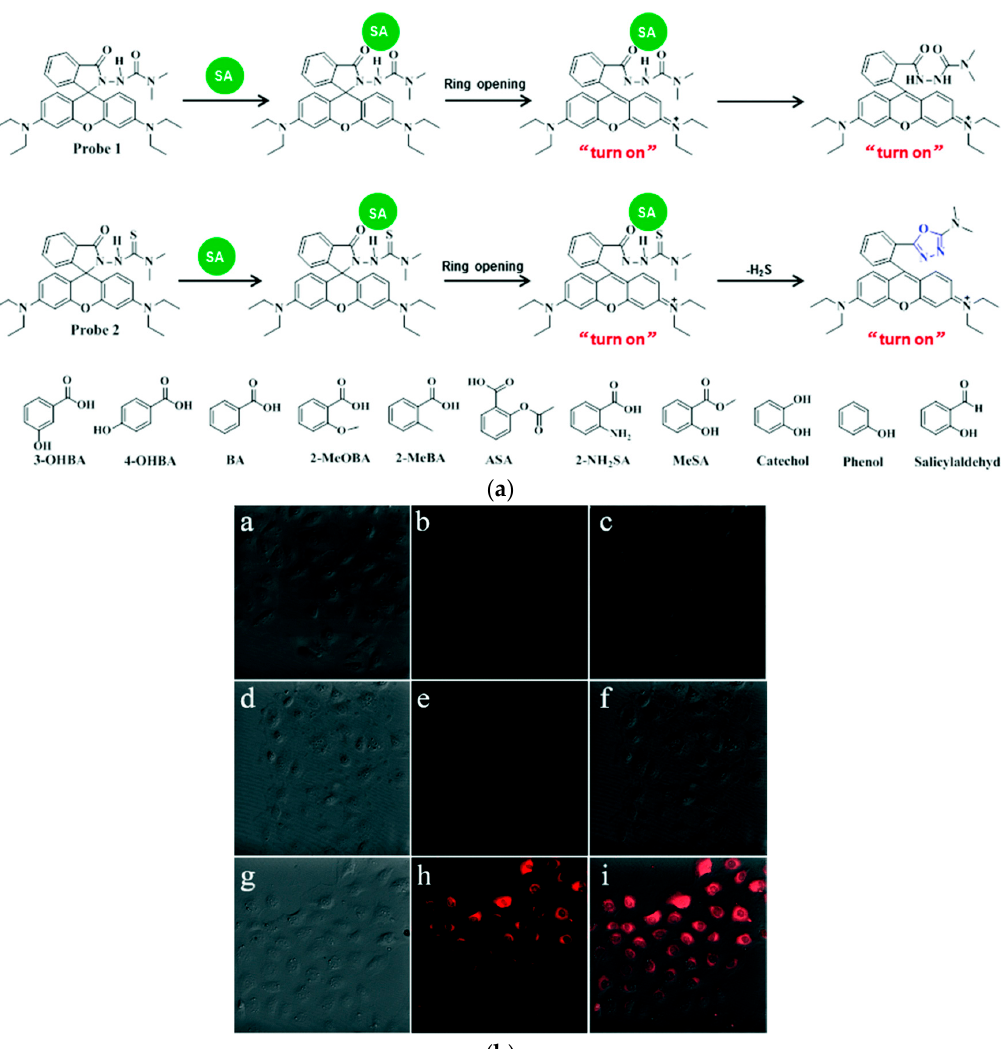
Figure 18. Detection of salicylic acid: ( a ) Proposed mechanism for detecting SA using probe 1 ( top ) and 2 ( middle ) and structures of tested SA analogues ( bottom ); ( b ) bright-field ( left ) and fluorescence ( middle ) and merged ( right ) images of NRK-52E cells; control ( top ) probe 2 ( middle ) and probe 2 + SA ( bottom ). Adapted with permission from [244].